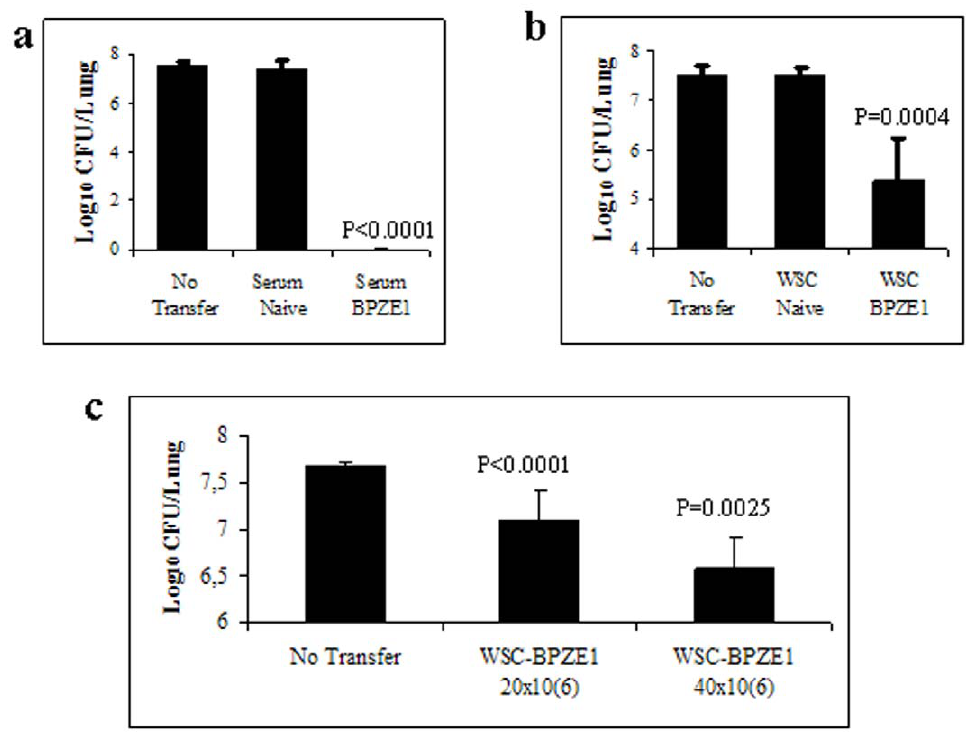
Figure 2. Transfer of protection by spleen cells and serum from BPZE1-immunized mice. 100 m l of serum ( a ) or 50 6 10 6 whole spleen cells (WSC) ( b ) or indicated amounts of WSC ( c ) from non-immunized (Naı¨ve) or BPZE1-immunized (BPZE1) BALB/c mice were transferred intraperitoneally to SCID mice 24 h before they were intranasally infected with virulent B. pertussis BPSM (1 6 10 6 CFU). Non-transferred SCID mice (No transfer) served as controls. The mice were sacrificed 7 days after challenge, and CFUs in the lungs were counted. The results are expressed as means of log CFU values per lung from 5 mice per group ( 6 standard error) and are representative of three independent experiments.